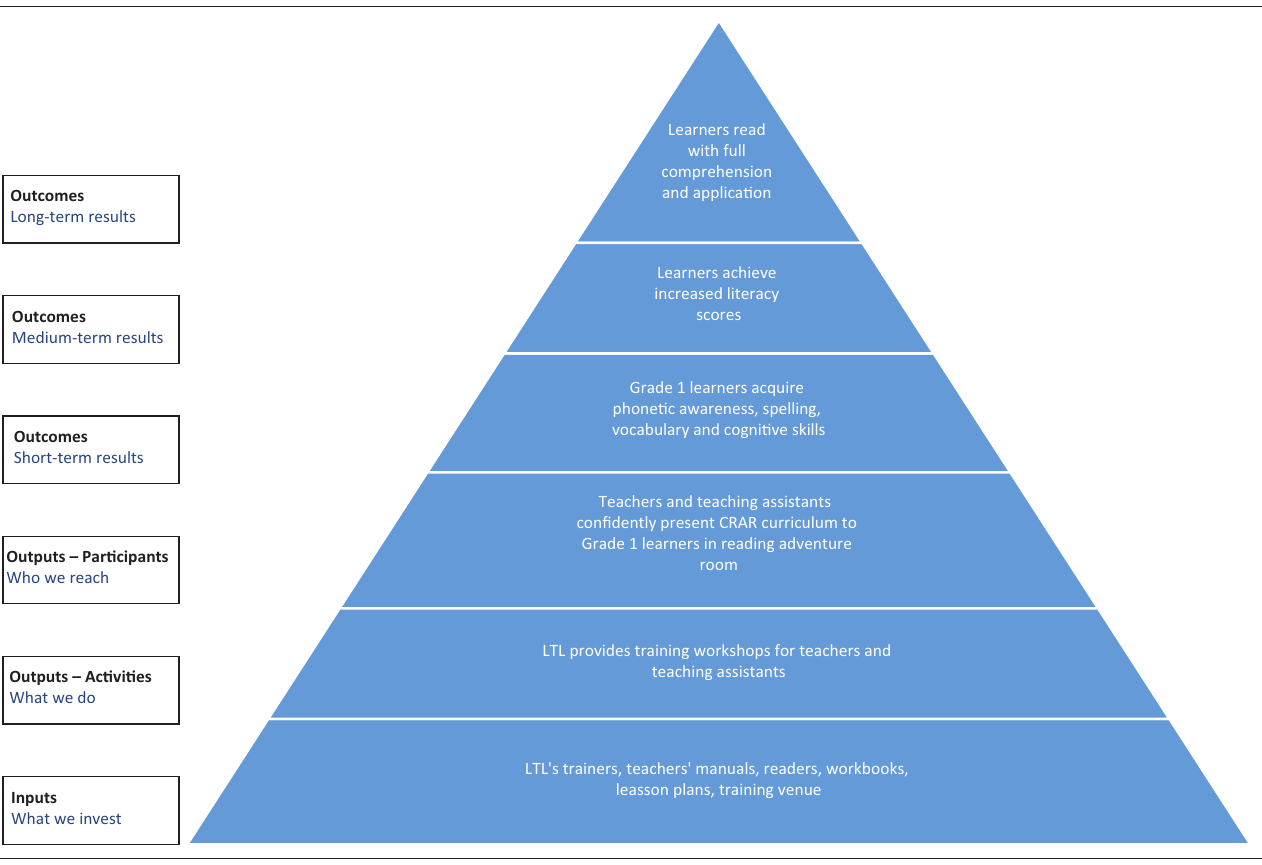
FIGURE 1: Programme theory of Living through Learning’s Coronation Reading Adventure Room